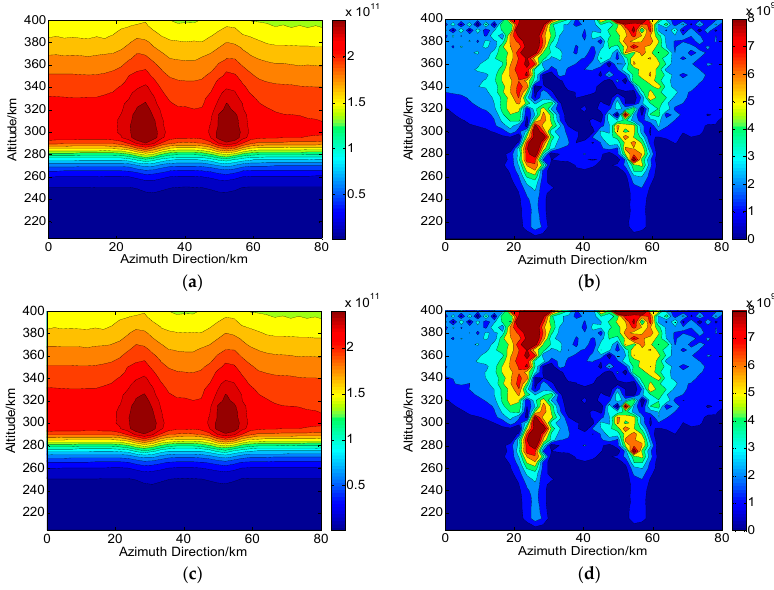
density is electrons · m − 3 . Remote Sens. 2017 , 9 , 1169